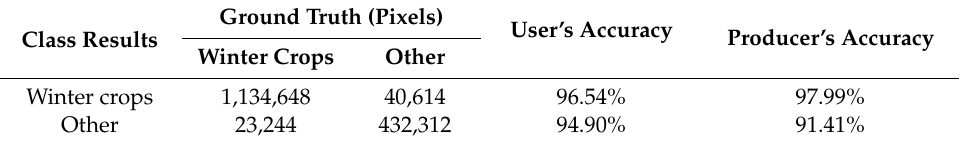
Table 1. Results of accuracy validation for winter crops map (WCM).